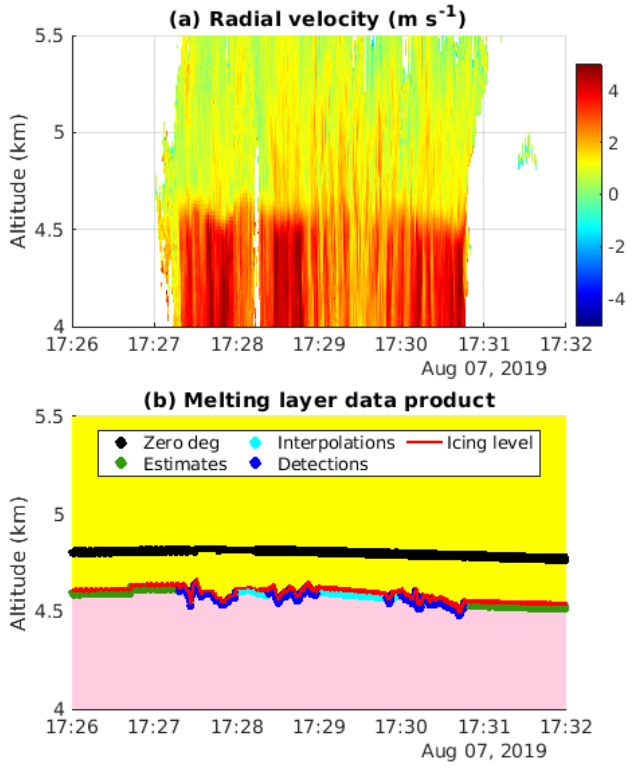
Figure 3. Example of the melting layer product: ( a ) radial velocity and ( b ) melting layer field where yellow (pink) indicates data above (below) the icing level (red line). Detections (dark blue), interpolations (light blue), and estimates (green) are marked with dots. Times are in UTC.